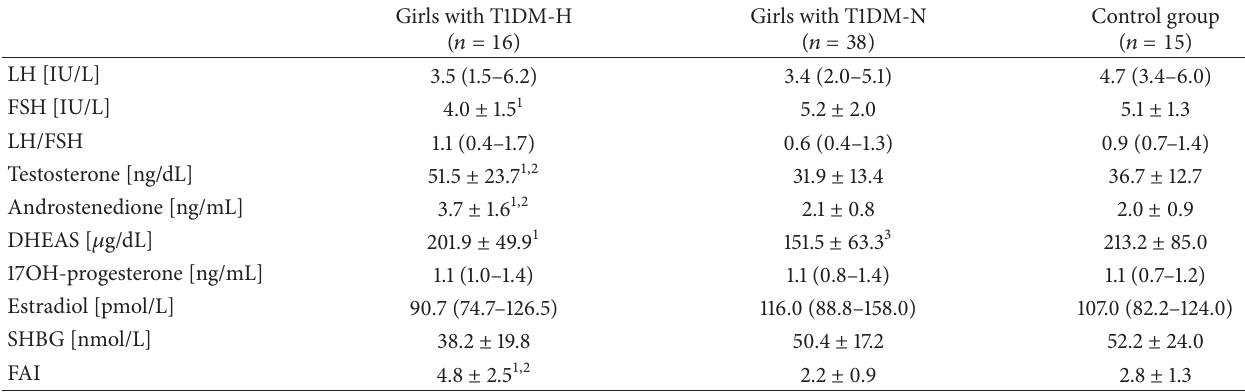
Table 2: Hormonal characteristics of adolescent girls with type 1 diabetes mellitus with (T1DM-H) and without hyperandrogenemia (T1DM- N) and healthy, regularly menstruating girls without hyperandrogenemia (control